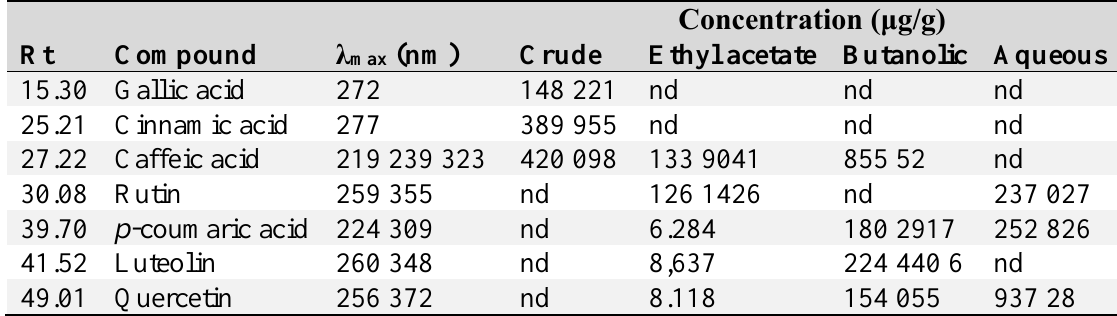
Table 3. Retention time (Rt), UV-Vis wavelengths of maximum absorption (λ and concentration of phenol